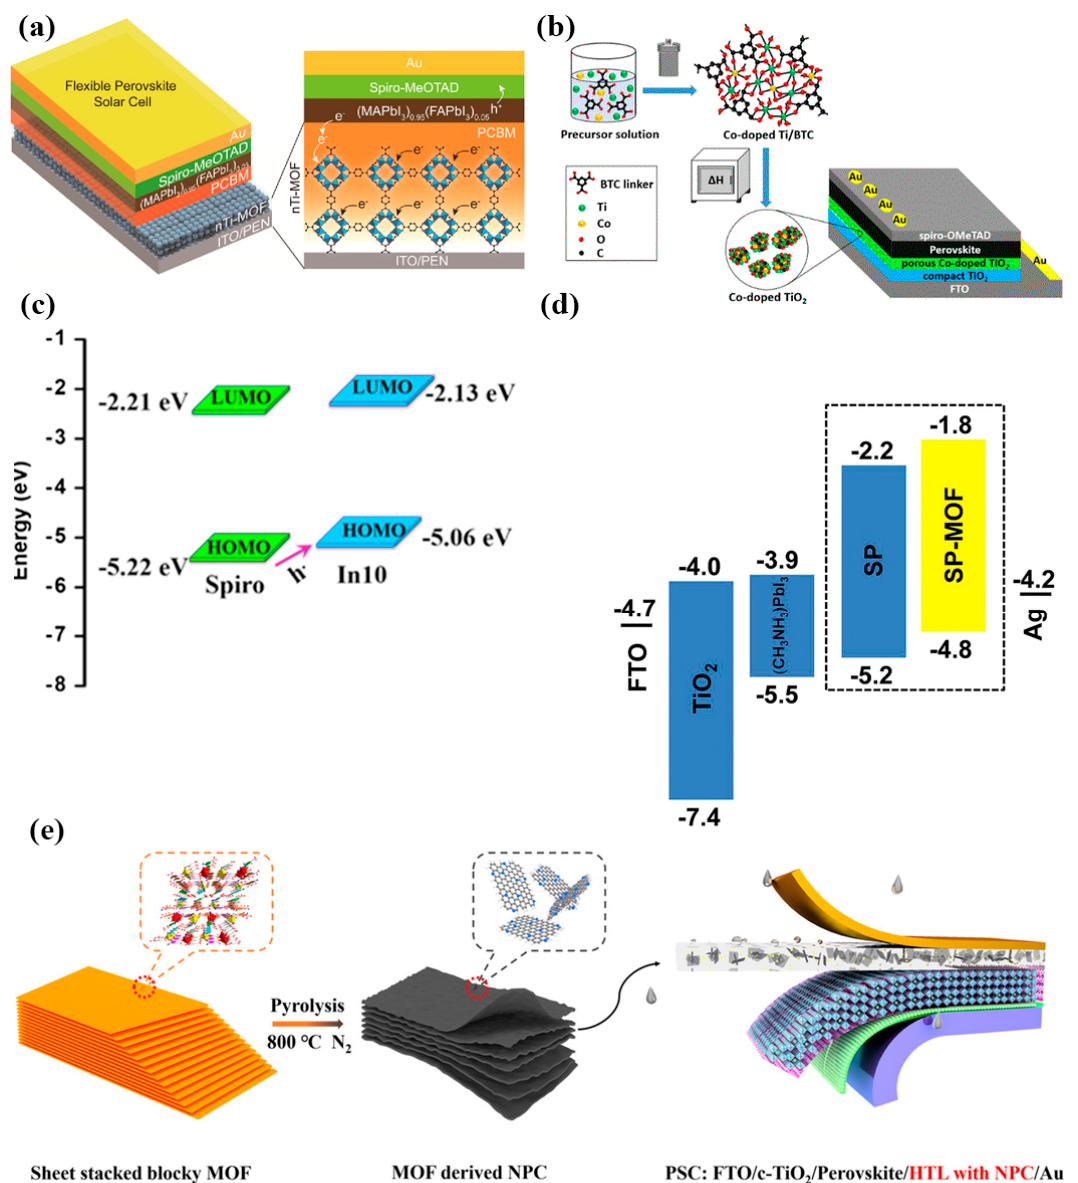
Figure 4. ( a ) Energy levels of Spiro-OMeTAD and In10, ( b ) J–V curves of HTM, and HTM/In10 with different amounts of In10 [59]. ( c ) The reflection spectra of Spiro-OMeTAD (SP) and SP-MOF samples, ( d ) energy levels of PSC with Spiro-OMeTAD (SP) and SP-MOF as HTL [60]. ( e ) The scheme of direct MOF crystals pyrolysis into graphitic NPC as HTL [61].